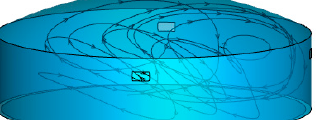
Figure 7. Streamtraces inside the tank for the floating-deck height of 8.45 m.